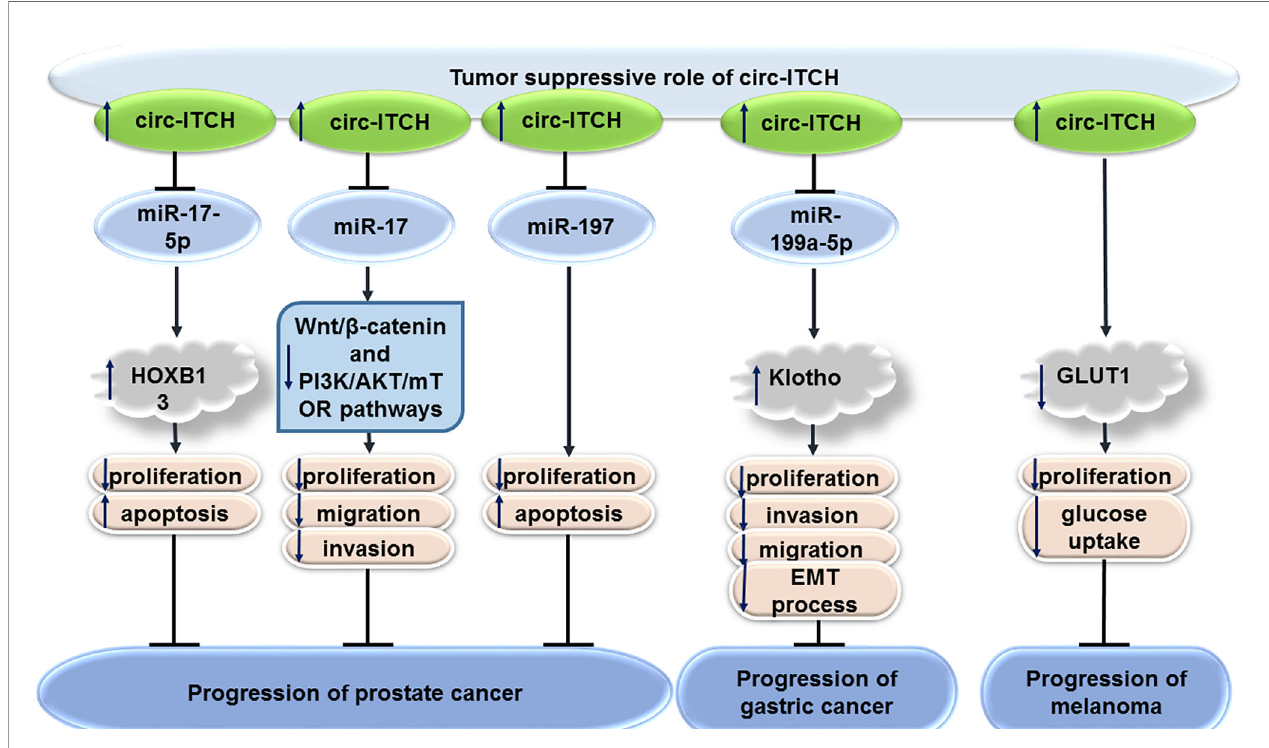
FIGURE 4 | Tumor suppressor role of circITCH in prostate cancer, gastric cancer and